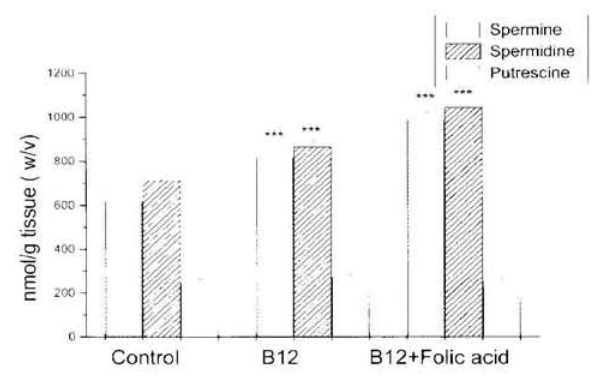
Figure 1. Spermine, spermidine and putrescine levels in liver tissue of rats treated with B12 and folic acid. Vitamin B12 in a single daily dose of 0.5 mg / animal i.m. during seven days. The second experimental group received vitamin B12 (in the same dose) plus folic acid (2.5 mg/animal) during seven days. Control group received 0.9 % NaCl instead of vitamins; ***p <0.001 compared to controls)